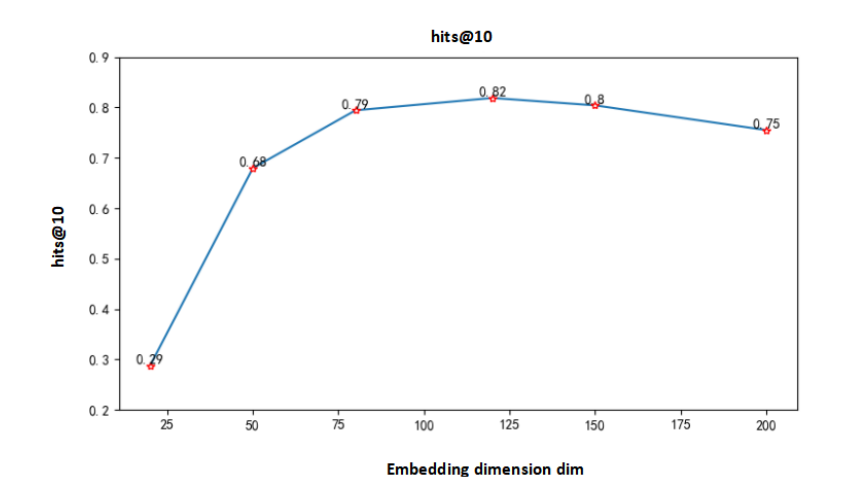
Figure 12. Hits@10 values under different embedding dimensions.